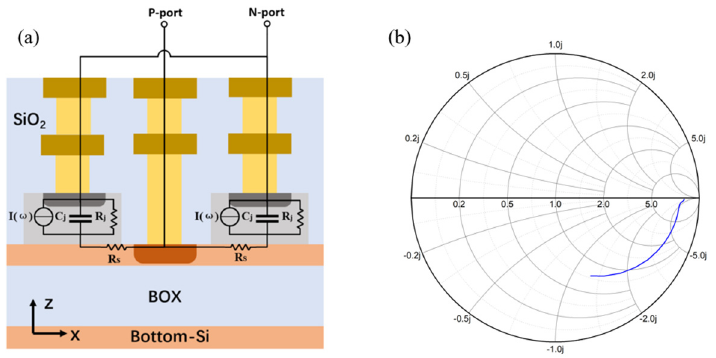
Figure 5. ( a ) The proposed equivalent circuit model of mode-evolution-based photodetector. ( b ) The simulated reflection coefficient ( S 22 parameter) versus frequency (from 100 MHz to 60 GHz) of mode-evolution-based coupled photodetector with 10 mW input optical power and − 1 V bias voltage.